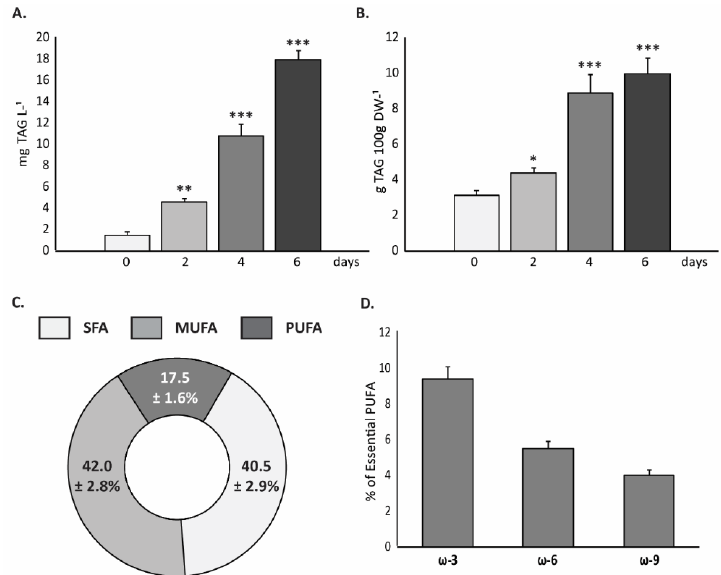
Figure 2. Lipid profile of H. coffeaeformis . ( A ) Production of triacylglycerides (TAG) by the marine diatom cultured at 20 ℃ in the photobioreactor. ( B ) TAG content (g TAG 100 g∙DW −1 ) ( C ) Percentage composition of saturated (SFA), mono-unsaturated (MUFA) and poly-unsaturated (PUFA) fatty acids after 6 days of growing H. coffeaeformis in the photobioreactor. ( D ) Relative content of essential omega (ω) -3, -6 and -9 fatty acids in H. coffeaeformis after 6 days. The graphics show average values ± their standard deviation (n = 3). * stands for statistically significant (p < 0.05), ** highly significant (p < 0.01) or *** very highly significant differences (p < 0.001) between conditions, respectively.